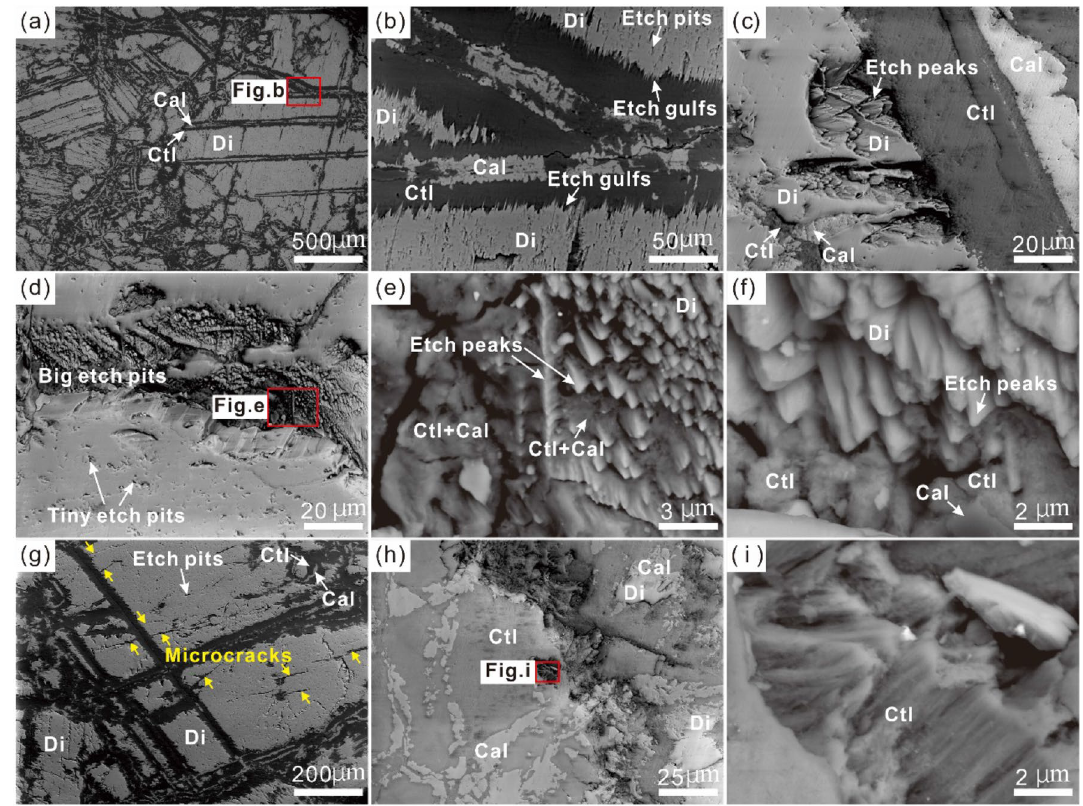
Figure 6. Backscattered electron (BSE) images of serpentinized diopsidite from the Yushishan area. ( a–c ) Many etch pits, etch gulfs, etc. peaks on diopside. ( d–f ) Conical-shaped and sawtooth-shaped etch peaks observed on diopside. Note the calcite and chrysotile around etch peaks. ( g ) Microcracks (yellow arrows) on diopside. ( h-i ) Fibrous chrysotile in